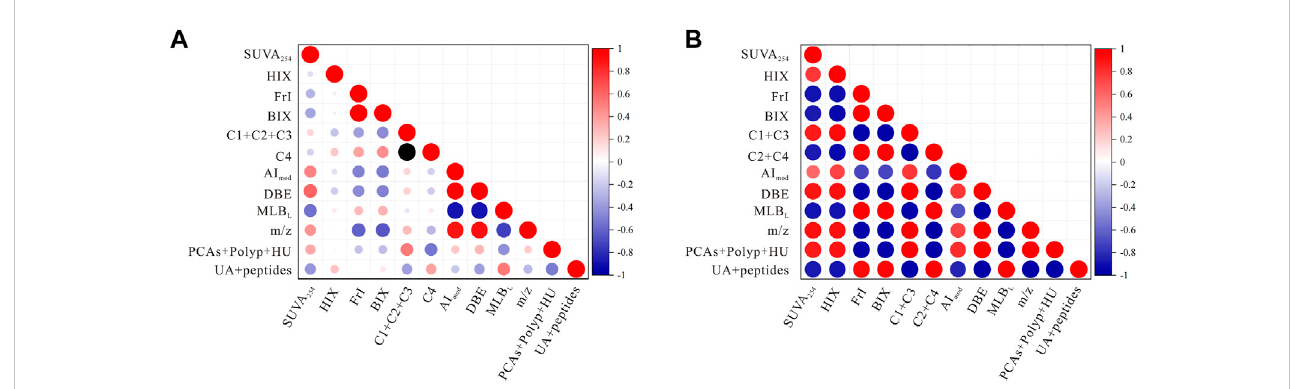
FIGURE 5 Correlation matrix based on optical and molecular parameters of (A) WEOM in sediment and (B) dissolved organic matter (DOM) in water.